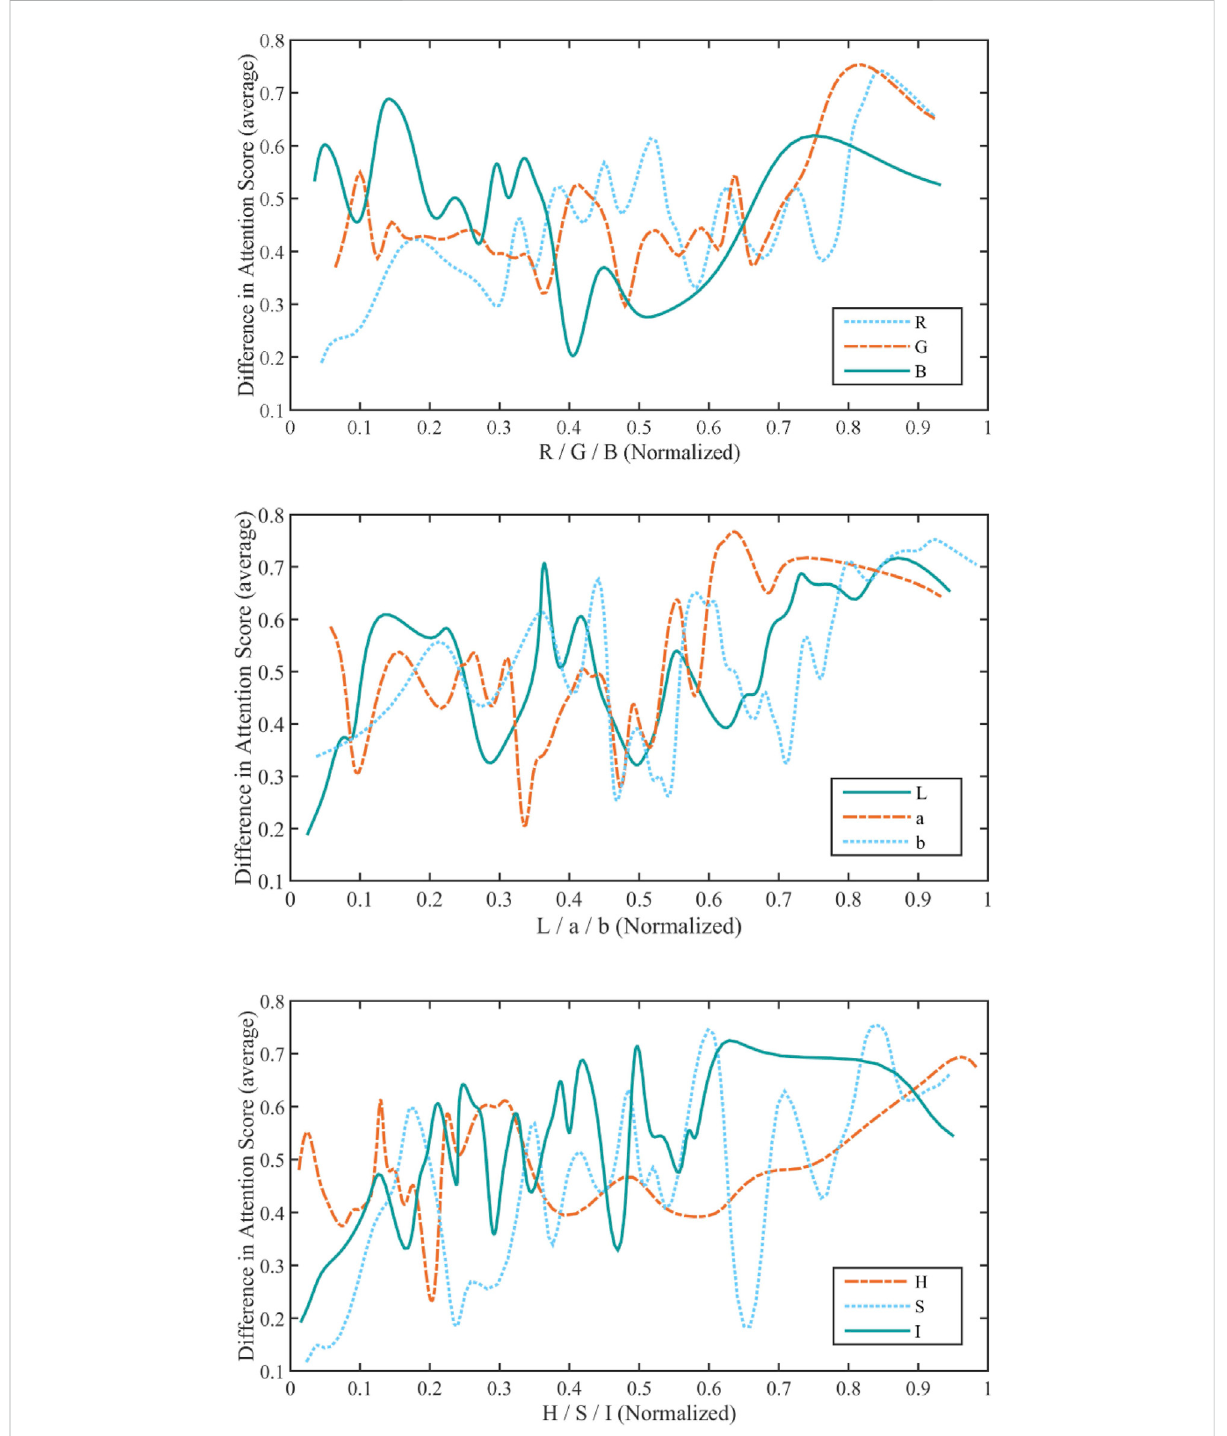
FIGURE 2 A statistic of the attention score of each color component of the RGB, CIELab, and HSI color spaces for colors corresponding to a DAS greater than0.1.Inthethreecolorspaces,eachcomponentofcolorisnormalizedto[0,1].AndtheMIC betweeneachcomponentandtheADSiscalculated (MIC(R,DAS)=0.57,MIC(G,DAS)=0.42,andMIC(B,DAS)=0.36;MIC(L,DAS)=0.61,MIC(a,DAS)=0.52,andMIC(b,DAS)=0.76);MIC(H,DAS)=0.37, MIC (S,DAS) = 0.41, and MIC (I,DAS) =